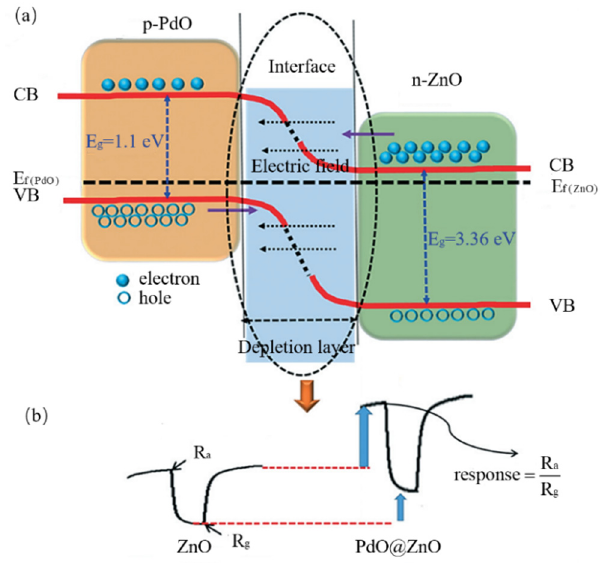
Figure 6. Schematic diagram of the mechanism of core-shell structure. Reprinted from [109]. ( a ) The energy band diagrams of PdO-ZnO heterojunction; ( b ) Response signals of the prisitine ZnO nanostructure and PdO-ZnO heterojunction.